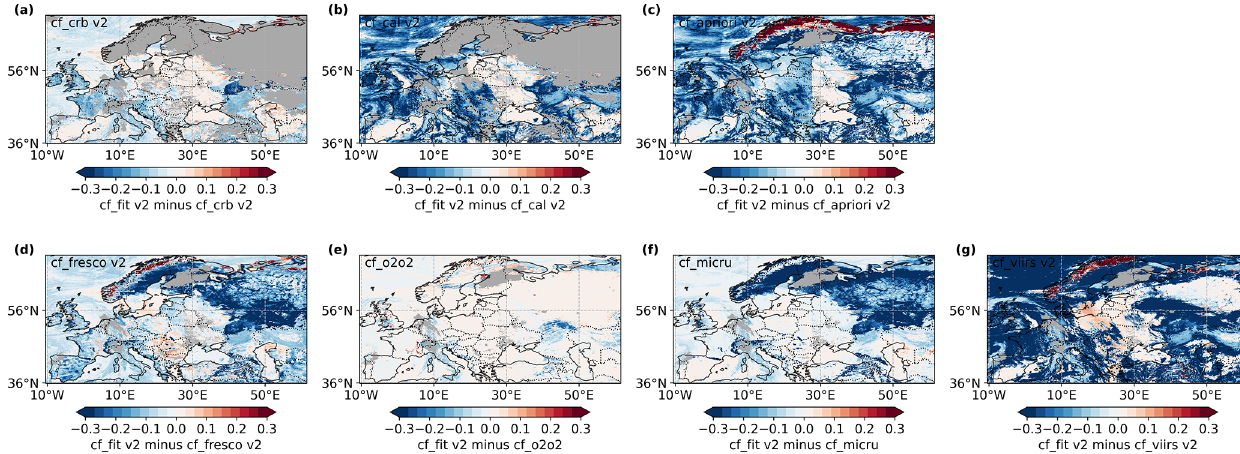
Figure 8. Differences between the version 2 cloud fractions from (a) ROCINN CRB, (b) ROCINN CAL, (c) OCRA a priori, (d) FRESCO, (e) O 2 –O 2 , (f) MICRU, and (g) VIIRS and the cloud fraction from the NO 2 fitting window (cf_fit) for Europe and the spring day (4 April